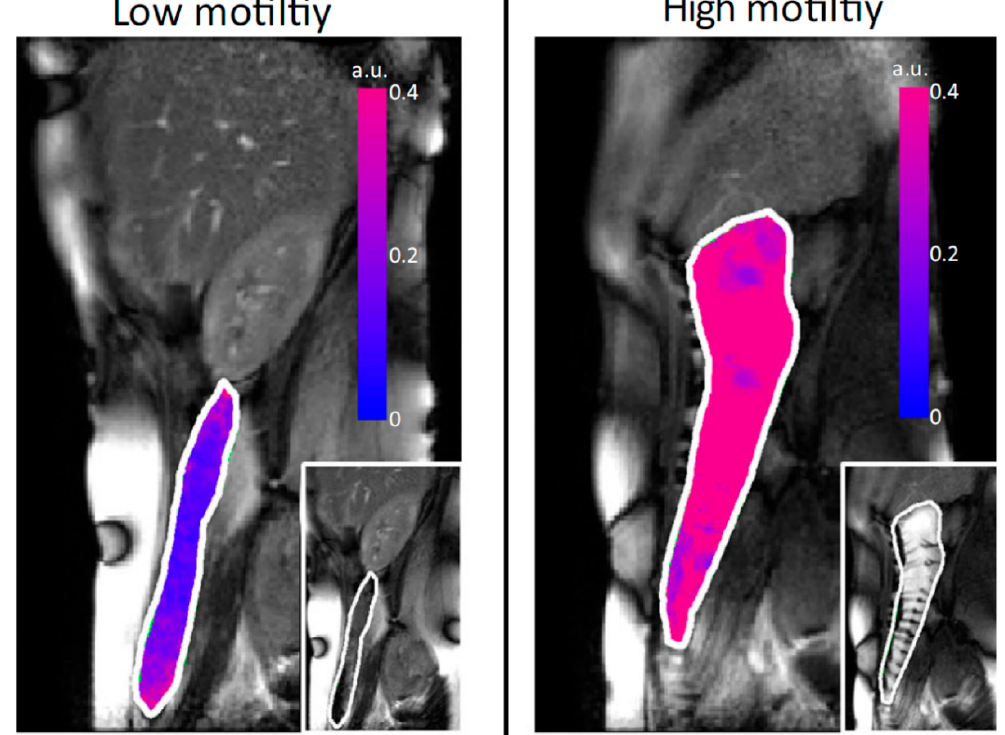
Figure 1. Motility assessment by the cine MRI technique. The figure depicts overlay (red/blue) of standard deviation of Jacobian. Reproduced from [28], Blackwell Publishing LTD, 2015 with permission.